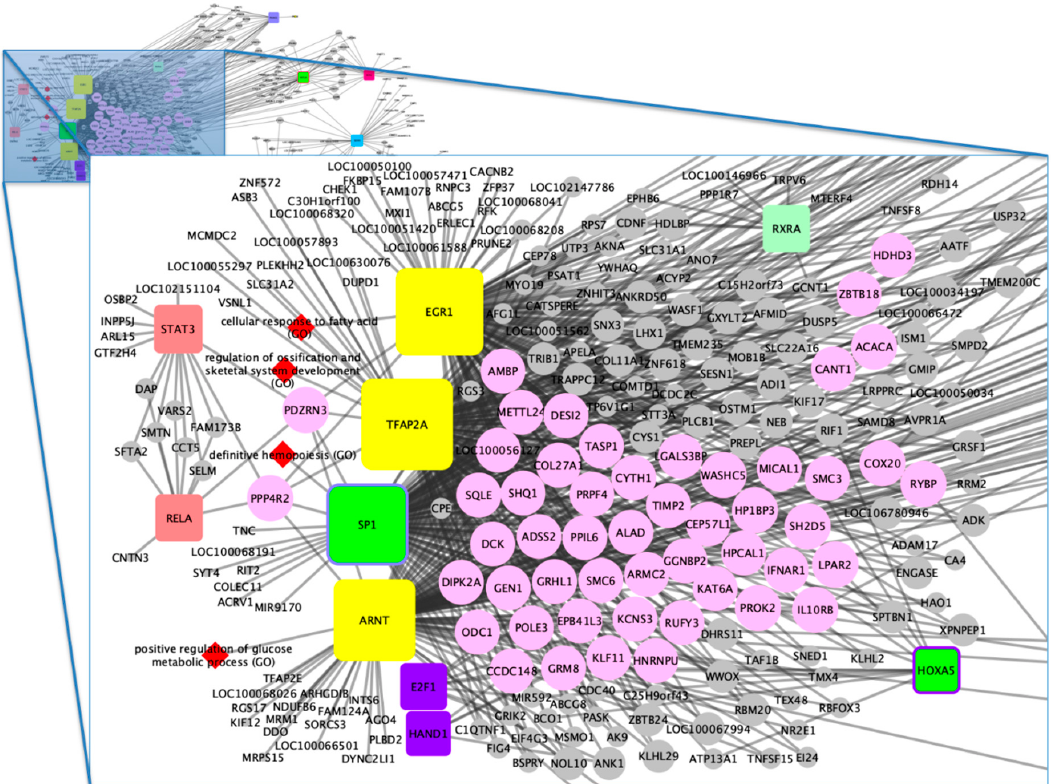
Figure 2. Horse performance gene–transcription factor (TF) network, focus 1. Rounded square nodes represent the TFs, wherein four main TFs are highlighted: EGR1, TFAP2A, SP1, and ARNT. Yellow nodes are associated with three or more groups, while those with two colors (interior and border) represent 2 groups, and nodes with one color represent only one group*. Red diamond nodes are the TF-related biological processes. Gray nodes are the identified candidate genes, whereas the main candidate genes related with horse performance are represented by light pink color. *Green nodes: group 1, purple nodes: group 2; salmon nodes: group 3; blue nodes: group 5; orange nodes: group 7; light green nodes: group 9.